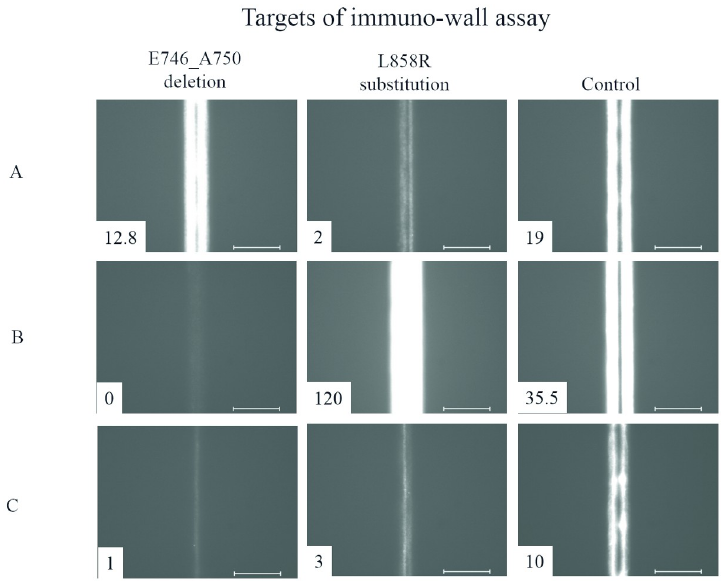
Fig 5. Representative fluorescence images from immunoassay of clinical samples. Samples containing (A) the E746_A750 deletion mutation (patient No. 11) and (B) L858R substitution mutation (patient No. 18). (C) A sample with no EGFR mutations (patient No. 9). Fluorescence intensity is indicated. Scale bars = 100 μ m.